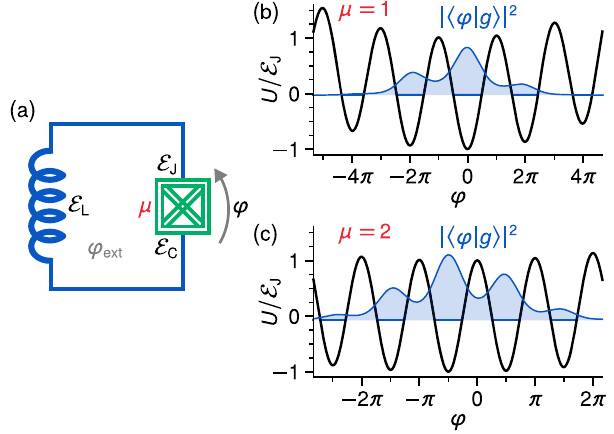
FIG. 1. Principle of magnifying the quantum phase fluctua- tions. (a) Electrical circuit diagram for a generalized Josephson junction (cross-hatched box) shunted by a superinductance. This junction possesses an internal parameter μ ¼ 1 ; 2 ; … that spec- ifies the periodicity of the Josephson potential. (b),(c) Potential and ground state probability density for the cases μ ¼ 1 and μ ¼ 2 at φ π = 3 , showing the increase in the number of ext ¼ Josephson wells accessible to the ground